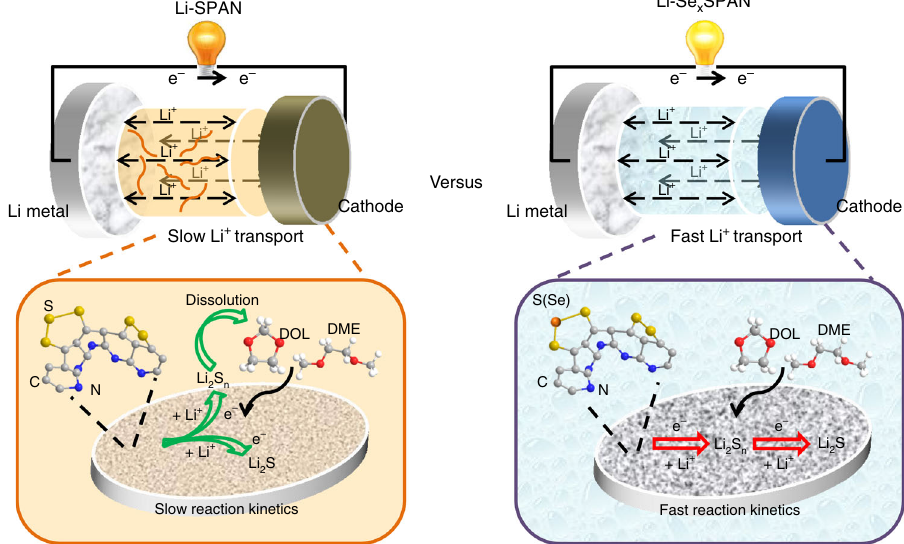
Fig. 6 The scheme of proposed reaction process. Small amount of Se-doping signi fi cantly enhances the redox conversion of polysul fi des and reaction kinetics, leading to ether-compatibility and superior performance of Li – Se 0.06 SPAN